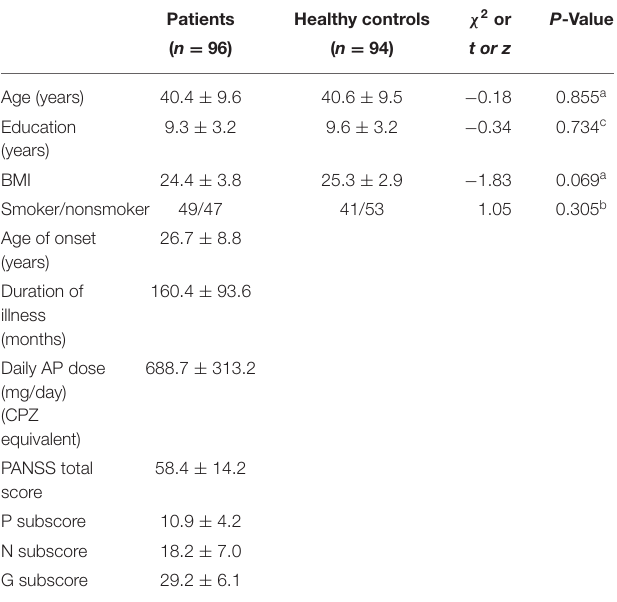
TABLE 1 | Demographic and clinical characteristics of schizophrenia patients and healthy controls (Mean ± SD).